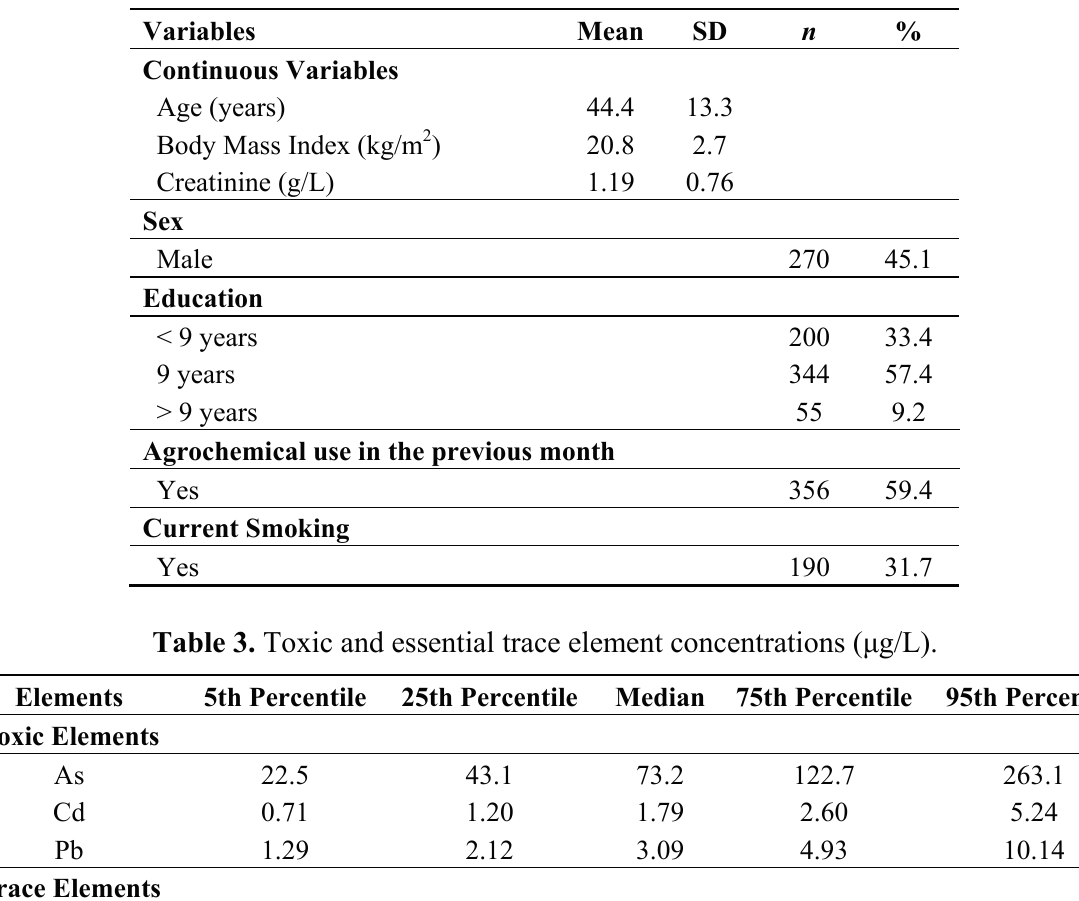
Table 2. Characteristics of the participants ( n = 599).